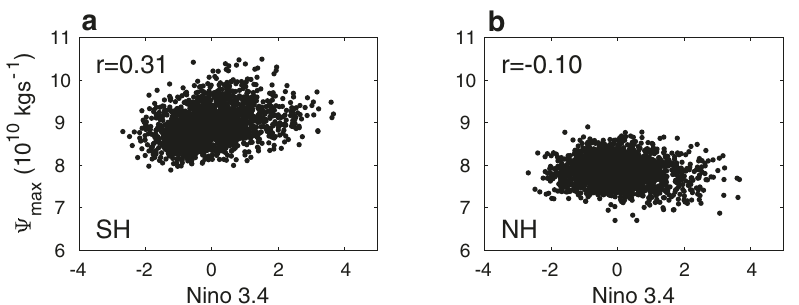
Fig. 6 The relation of ENSO and the Hadley cell strength. ( a ) SH and ( b ) NH Ψ max plotted against Nino 3.4 index from the FULL run. Correlations are shown in the top left